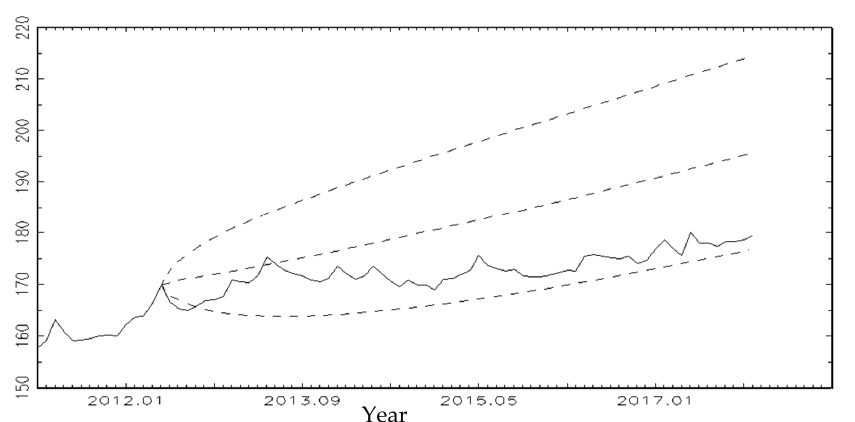
Figure A9. Time series forecasting in VAR model for IFB, the in-sample January 2000–May 2012,